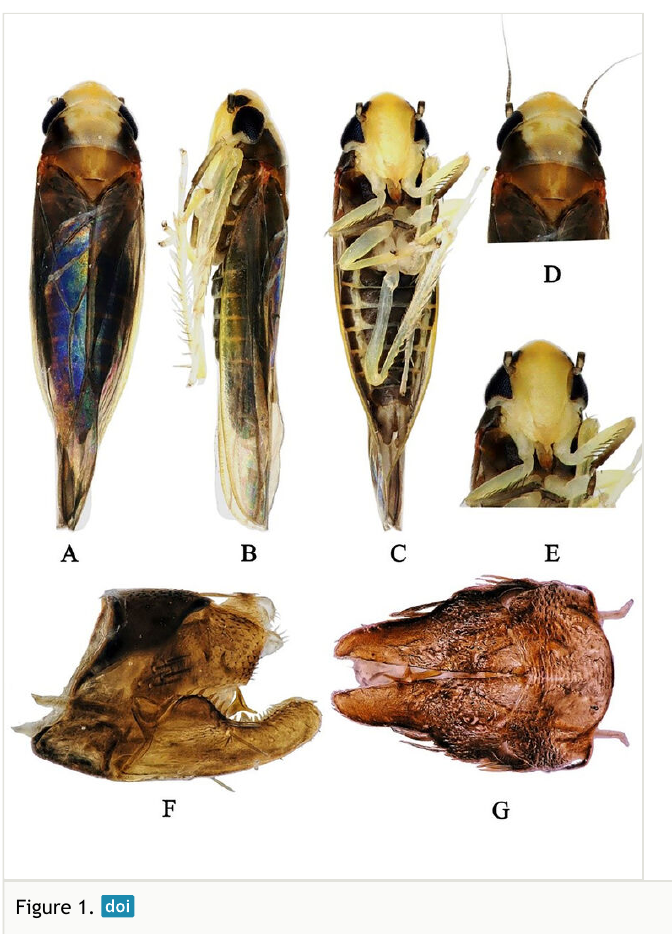
Anufrievia ventricosa sp. nov . A Habitus, dorsal view; B Habitus, lateral view; C Habitus, ventral view; D Head and thorax, dorsal view; E Face; F Genital capsule, lateral view; G Genital capsule, ventral